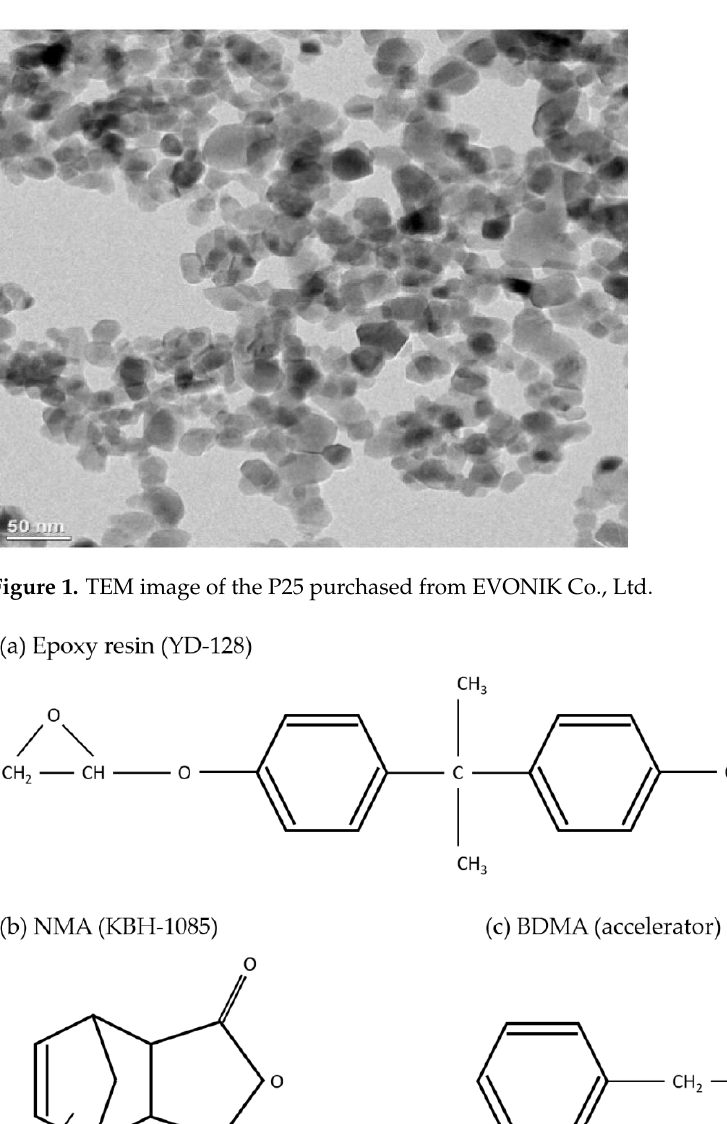
Figure 1. TEM image of the P25 purchased from EVONIK Co., Ltd.